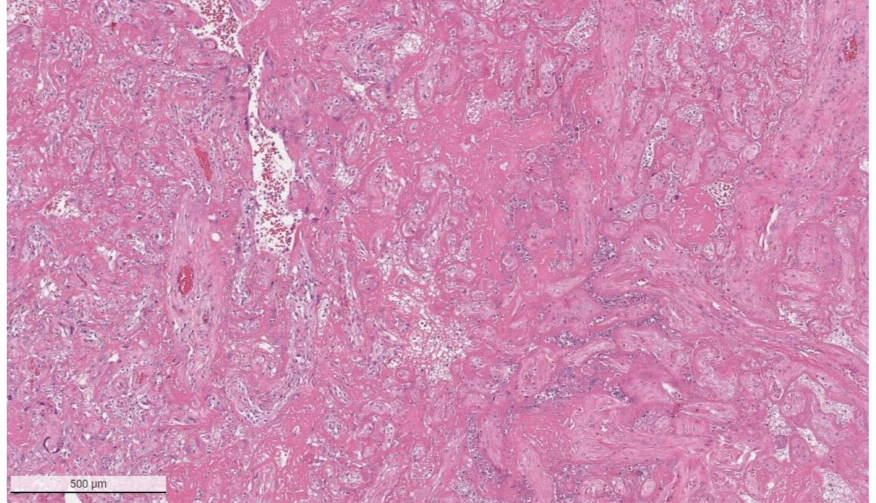
Figure 2. Massive perivillous fibrin deposition in a placenta from a stillborn fetus delivered to a mother with COVID-19. This placenta was positive for SARS-CoV-2 and had greater than 90% tissue destruction. Hematoxylin & eosin staining, ×